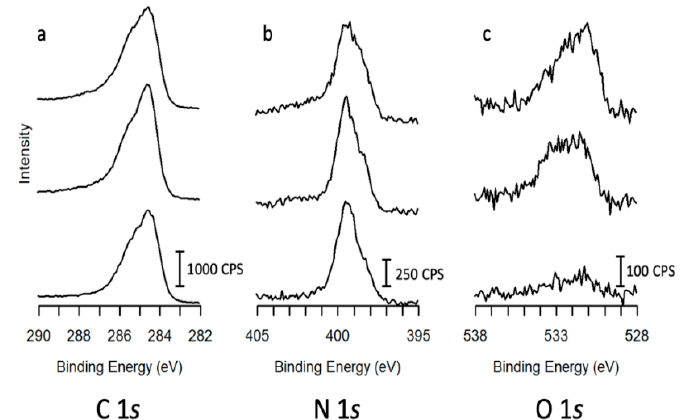
Figure 2. XPS spectra of PAni at various points during sample modification. The top line in each set of spectra is the pure PAni powder as received from the manufacturer. The middle line shows the sample after preparation and spin-coated onto indium tin oxide (ITO) (there was no signal from the indium of the underlayer of the ITO). The last set of spectra is of the thin film after gas cluster ion sputtering (GCIS) to identify the oxygen source. The polymer film was not made so thin as to reveal the ITO substrate. Therefore, the oxygen signal would be only from PAni and not the substrate. ( a ) shows the carbon 1s spectra; ( b ) is the nitrogen 1s spectra; ( c ) is the oxygen 1s. Table 1. Measured atomic percent composition (all errors are standard deviations with n = 3). See text for speciation atomic percentages.